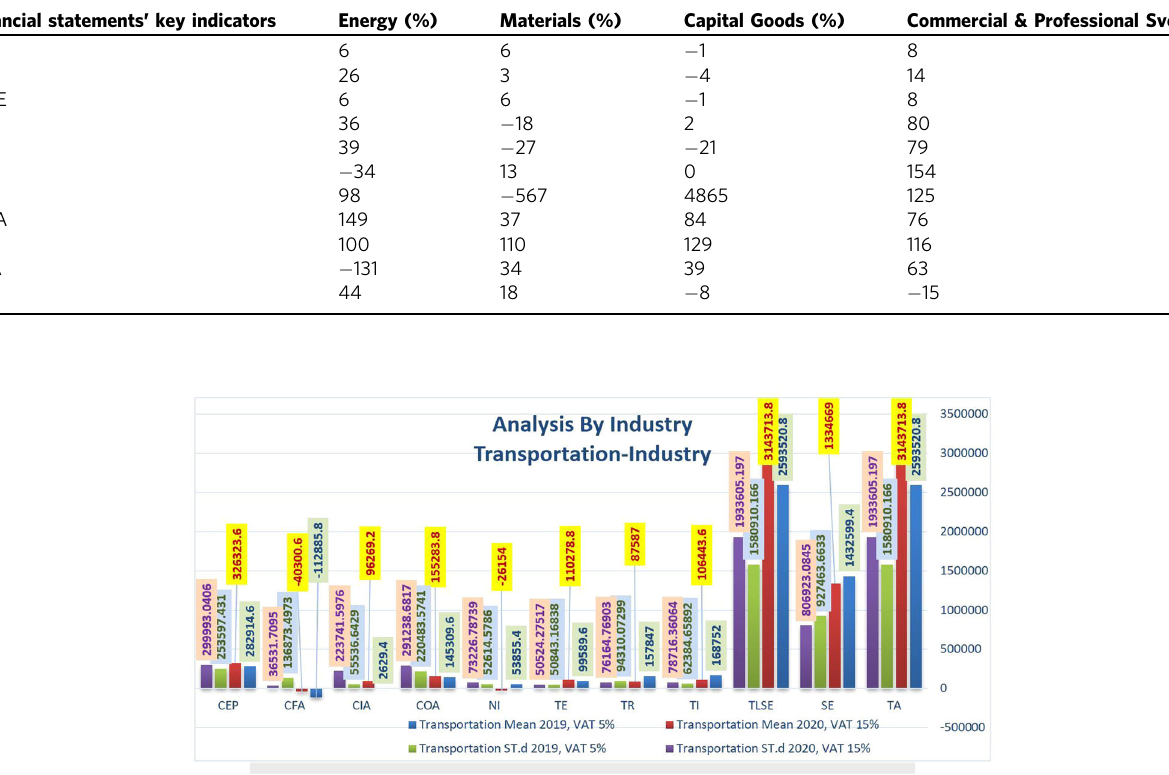
Fig. 7 Comparison of the fi nancial statements' key indicators in term of the average and standard deviation in Transportation industry before and after rising VAT.